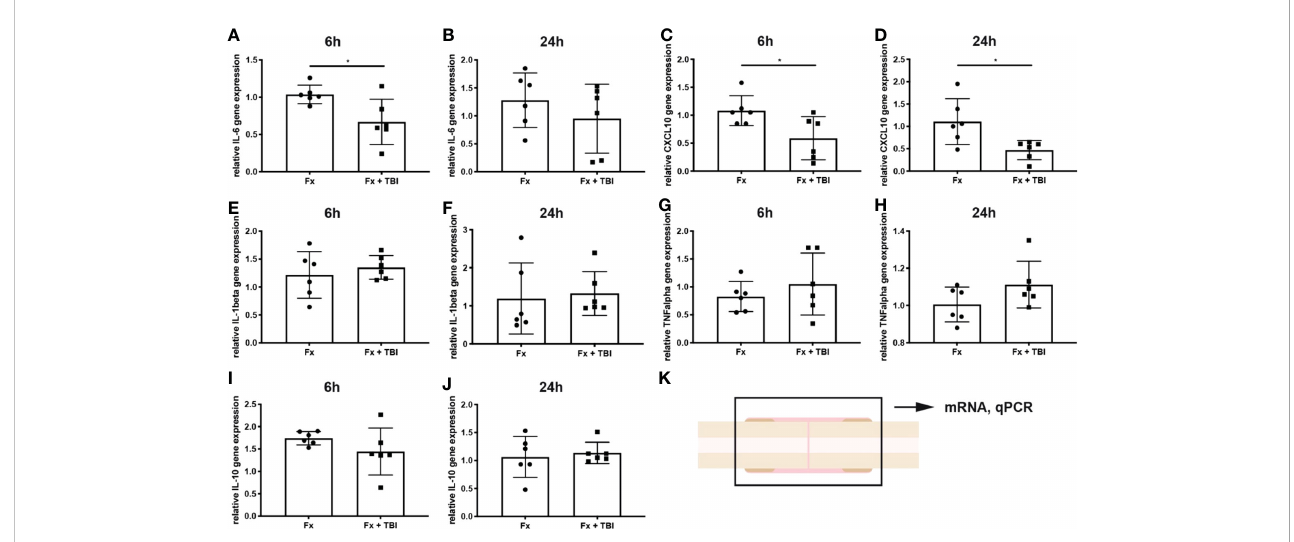
FIGURE 1 Local gene expression of in fl ammatory mediators in the hematoma. RNase-free sections of the fractured bones were cut, RNA was isolated and gene expression analyzed by qPCR. Data are normalized to the housekeeping gene B2M and the Fx group, respectively. (A) Relative IL-6 gene expression at 6h and (B) 24h after injury. (C) Relative CXCL10 gene expression at 6h and (D) 24h after injury. (E) Relative IL-1beta gene expression at 6h and (F) 24h after injury. (G) Relative TNFalpha gene expression at 6h and (H) 24h after injury. (I) Relative IL-10 gene expression at 6h and (J) 24h after injury. (K) Experimental design. * indicates p-value below 0.05 for comparison between Fx and Fx+TBI.